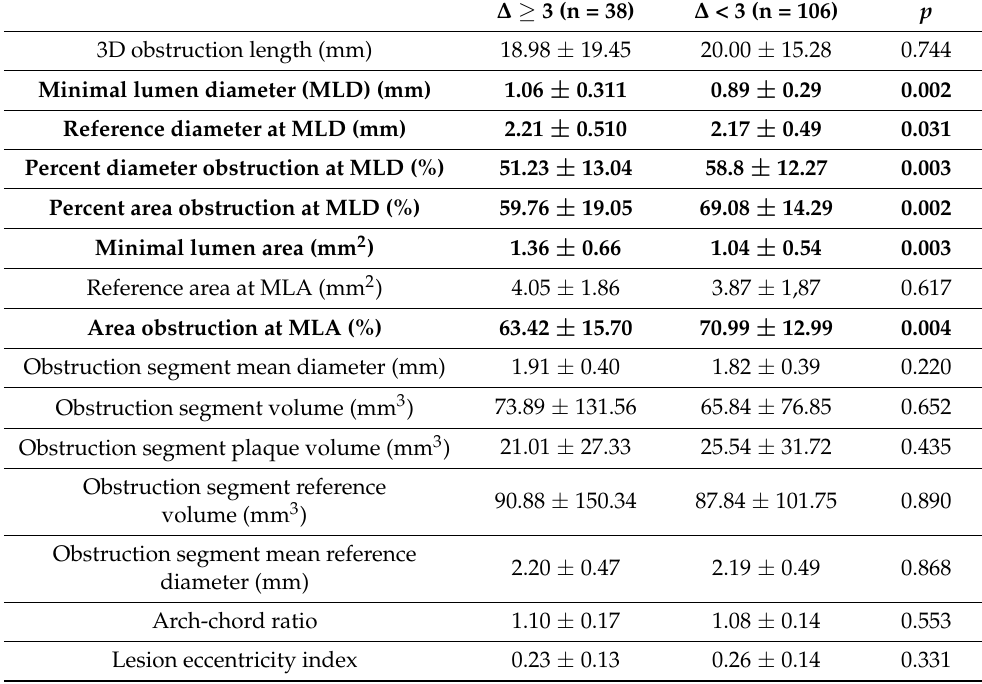
Table 4. 2/3D parameters when patients are separated into post-PCI TFC changes ∆ ≥ 3 or ∆ < 3.